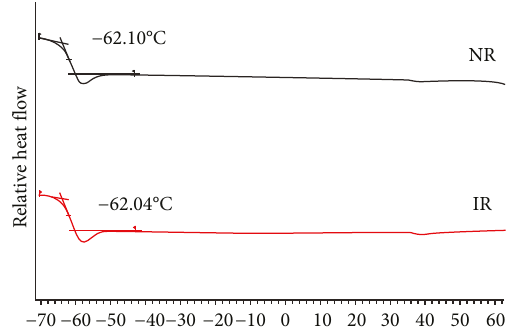
Figure 1: DSC thermograms showing the glass transition temperatures of NR and